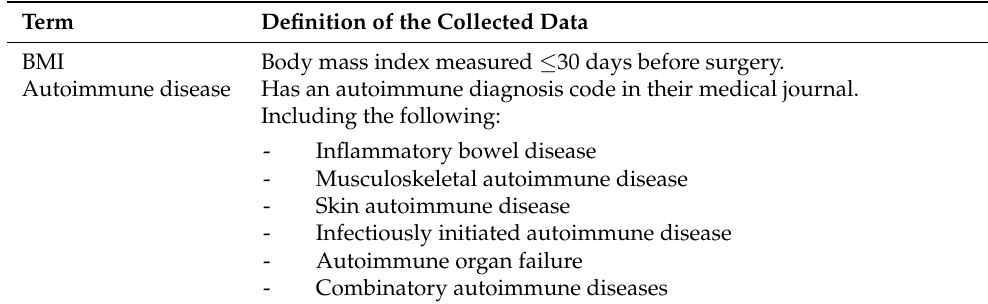
Table 1. Definition of